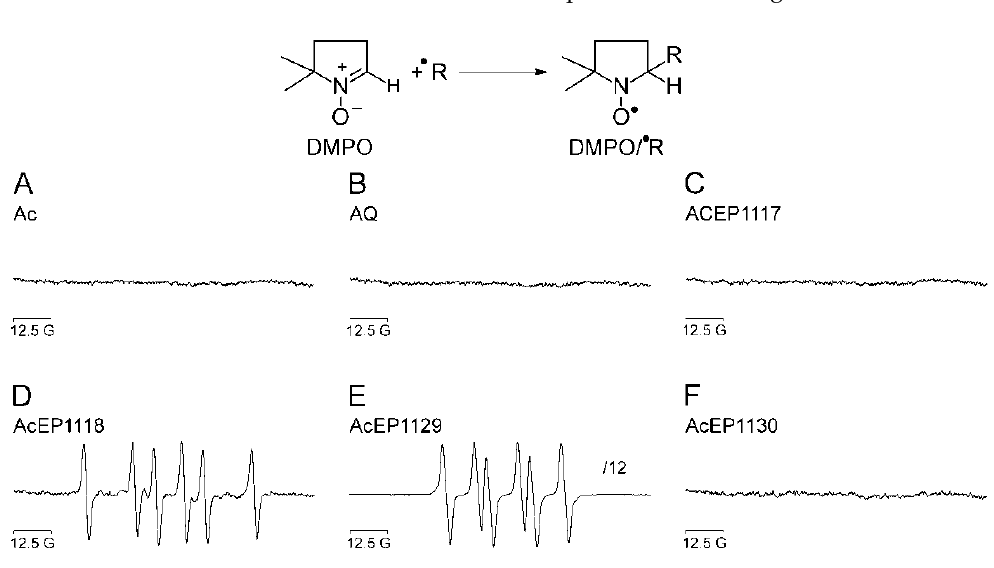
Figure 2. EPR spectra recorded after incubation of AcEPs and other compounds with Fe 2+ in the presence of the spin trap DMPO. The spectra were obtained after an incubation of 5 min of 500 µM FeSO 4 with ( A ) 500 µM anthracene (Ac), ( B ) 200 µM anthraquinone (AQ), ( C ) 500 µM AcEP1117, ( D ) 500 µM AcEP1118, ( E ) 500 µM AcEP1129 (intensity scaled-down by a factor of 12), or ( F ) 500 µM AcEP1130 in the presence of 40 mM DMPO in H 2 O at 25 °C. The graph shows representative spectra of three independent experiments.